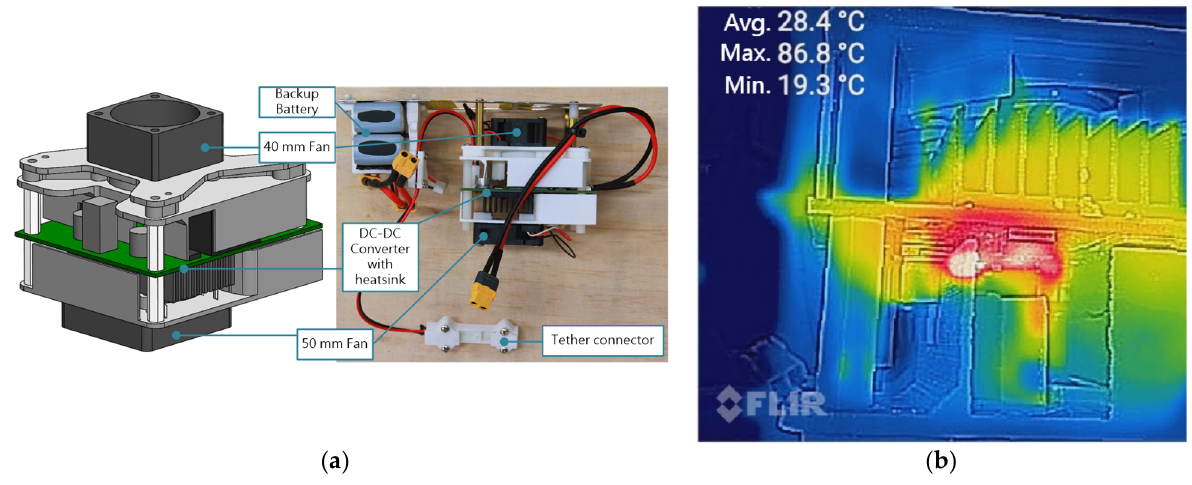
Figure 2. ( a ) The power supply module (PSM) consists of a DC-DC convertor, a heat sink, cooling fans, and a backup battery for emergency landing; ( b ) The thermal image of the DC-DC convertor providing 30 A at 24 V.